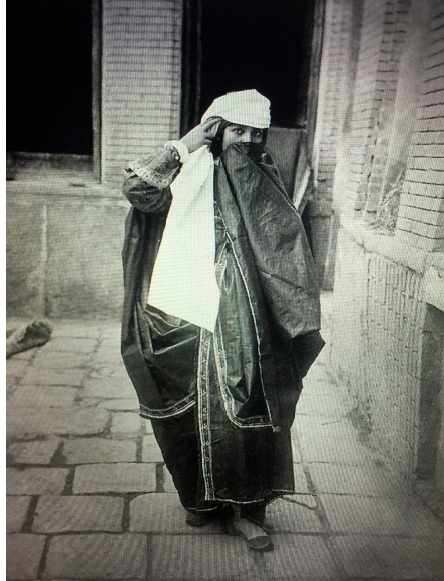
Figure 1. chador chaqchur Qajar era. source: http: // ghoolabad.com / article / 198-qajar-women-yazd / women. Photographer: Antoin Aeveuguin.